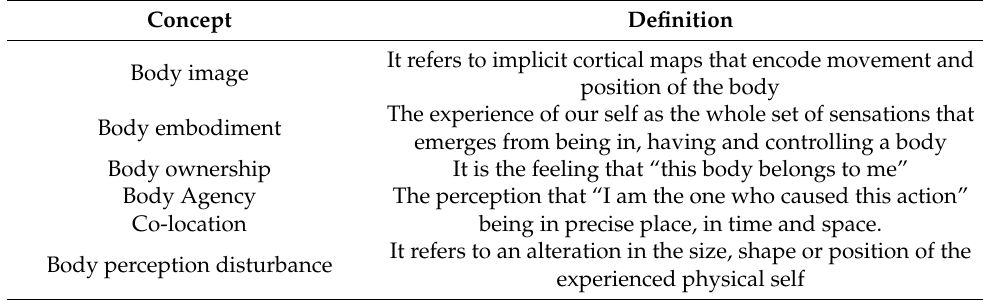
Table 3. Properties related to body perception and